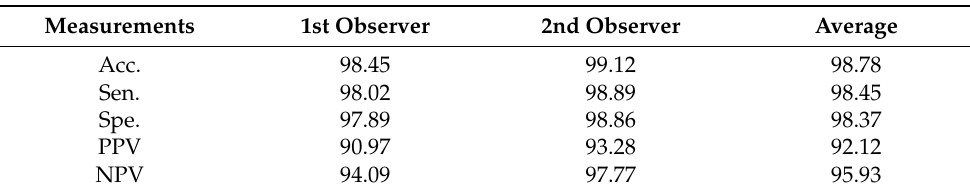
Table 2. The average values of five quantitative performance measures using the proposed trainable filters algorithm on the DRIVE dataset.